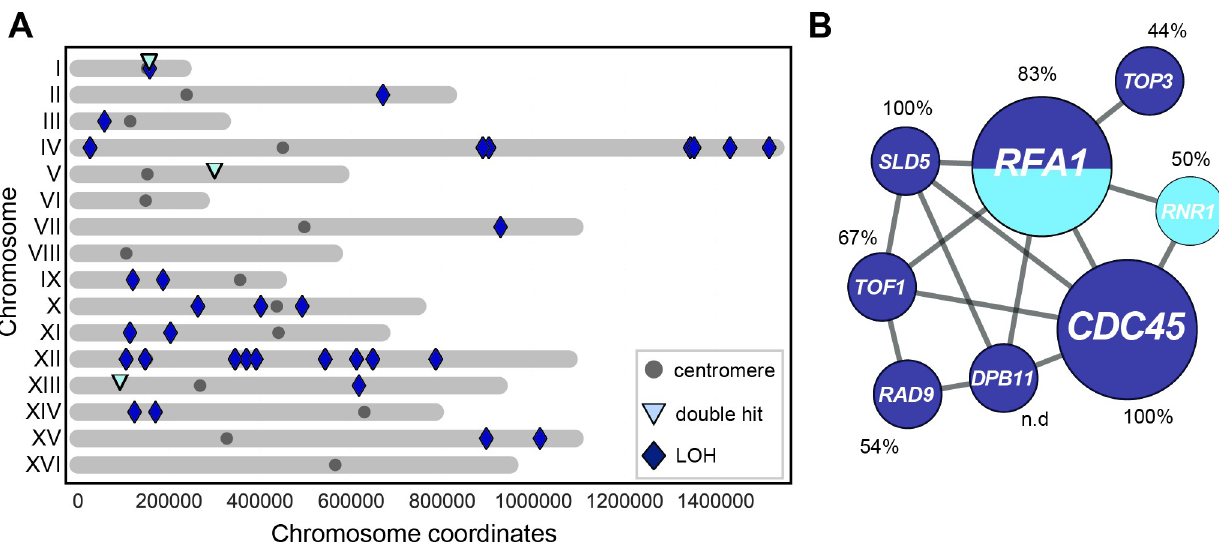
Fig 4. Homozygous mutations in diploids evolved in the presence of constitutive DNA replication stress. (A) Homozygous mutations (SNPs and small InDels of 1-55bp) detected in evolved ctf4 Δ /ctf4 Δ diploids clones distributed by chromosome (roman numbers). Dark blue diamonds represent loss of heterozygosity events (LOH). Light-blue triangles represent genes which contain two independent mutations (double hits) and the gray circles are the centromeres. The identities of the mutations shown here are reported in S6 Table. (B) DNA replication and DNA damage checkpoint genes with mutations in both copies in evolved ctf4 Δ /ctf4 Δ diploid clones. Gray lines represent evidence of genetic and physical interactions from the literature (https://string-db. org). Node diameter is proportional to the number of populations in which the gene was mutated. Dark blue represents LOH events, light blue represents double hits. Percentages refer to the average estimated frequency within populations of the clones carrying the respective mutation in homozygosity (LOH) or carrying both mutations (double hits).